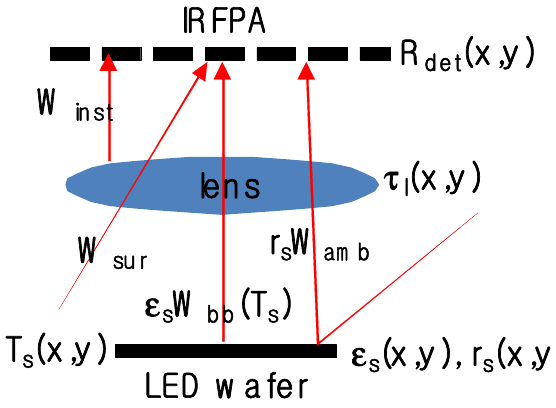
Figure 1. Schematic representation of quantitative infrared micro-thermographic measurement of an LED wafer.